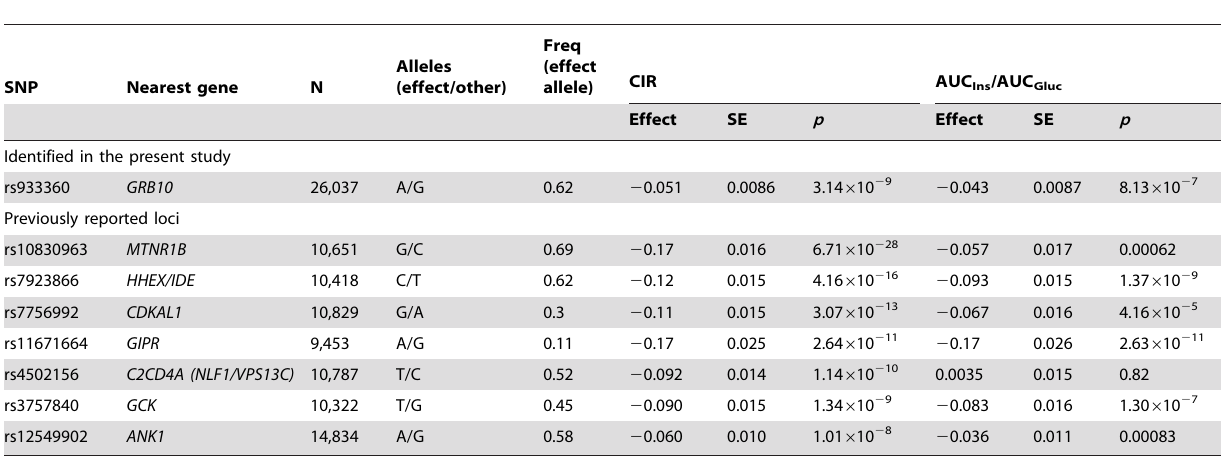
Table 1. SNPs associated with primary insulin secretion traits at genome-wide significance